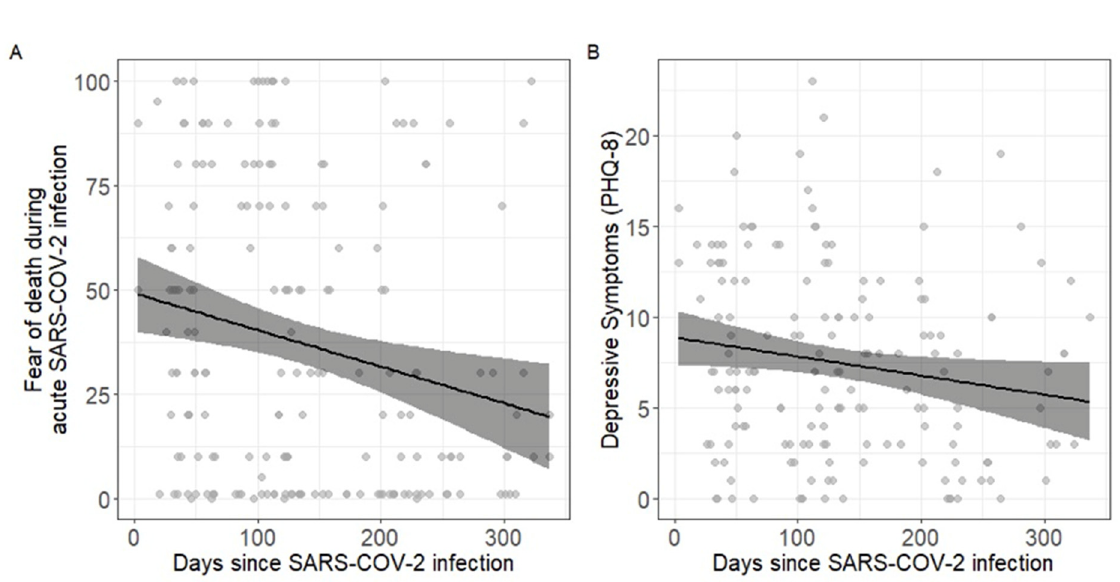
Figure 1. ( A ) Association between the fear of death during the acute SARS-CoV-2 infection (0 =